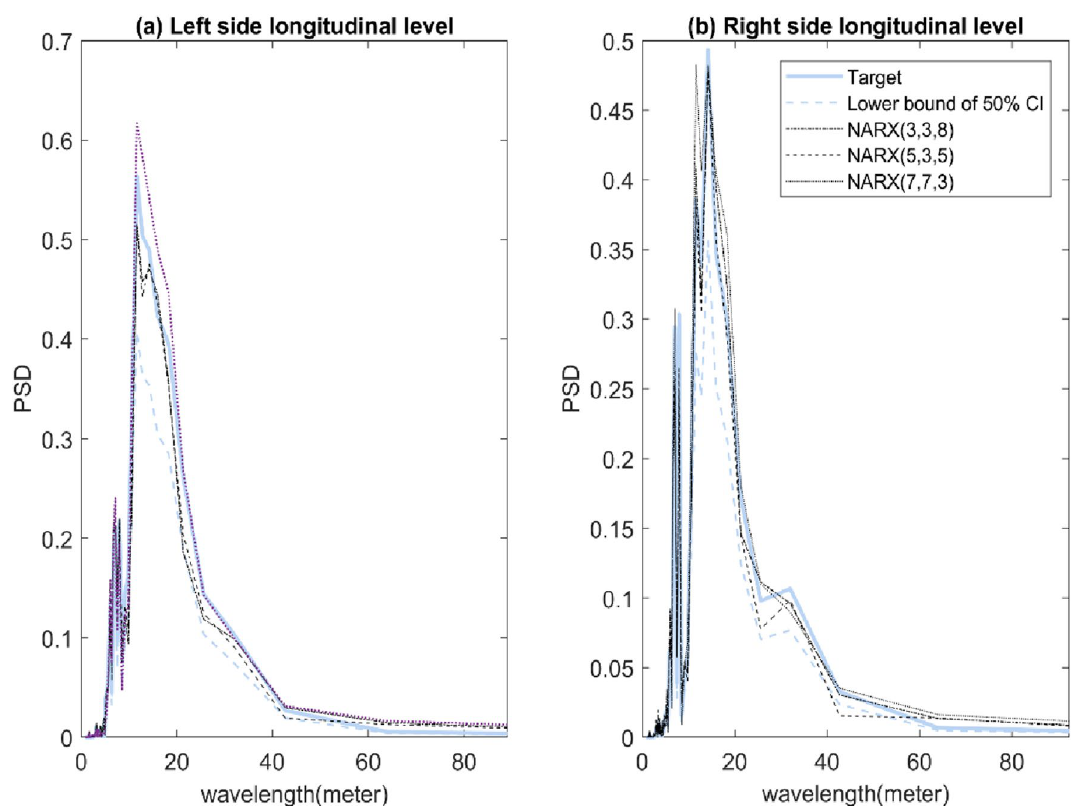
Figure 10. PSD comparison between artificial and actual longitudinal track level of ( a ) left rail, and ( b ) right rail for